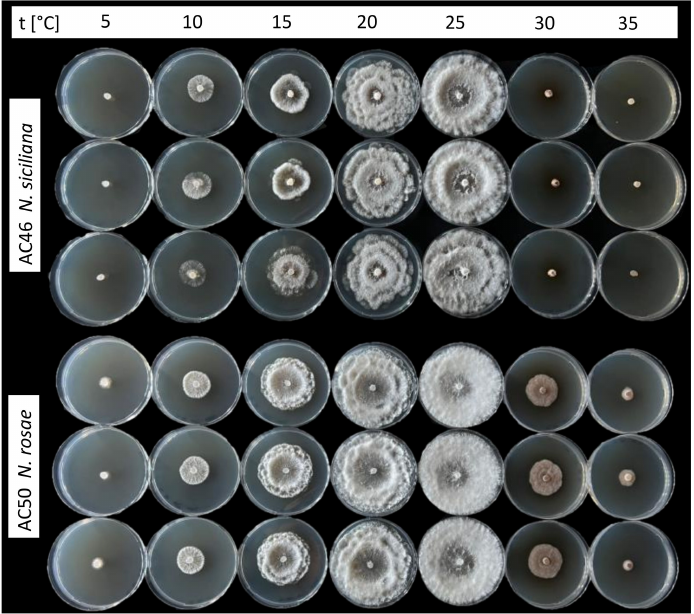
Figure 2. Effect of temperature on mycelial growth rate of two Neopestalotiopsis spp. isolated from avocado after 7 days of